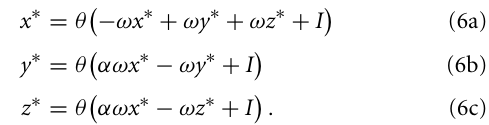
FIGURE 6 | The response of a relay network to input depends on connectivity. ( A ;left)Illustrationofarelaynetworkwithfeedbackconnections. (right) In a relay network, mean activation increases monotonically with the strength of input, but saturates for values of input greater than 10 2 . Black and blue lines represent nodes of the network in (A) (activation of the red node overlaps with that of the blue node). Solid lines, weights of w = 1000. Dashed